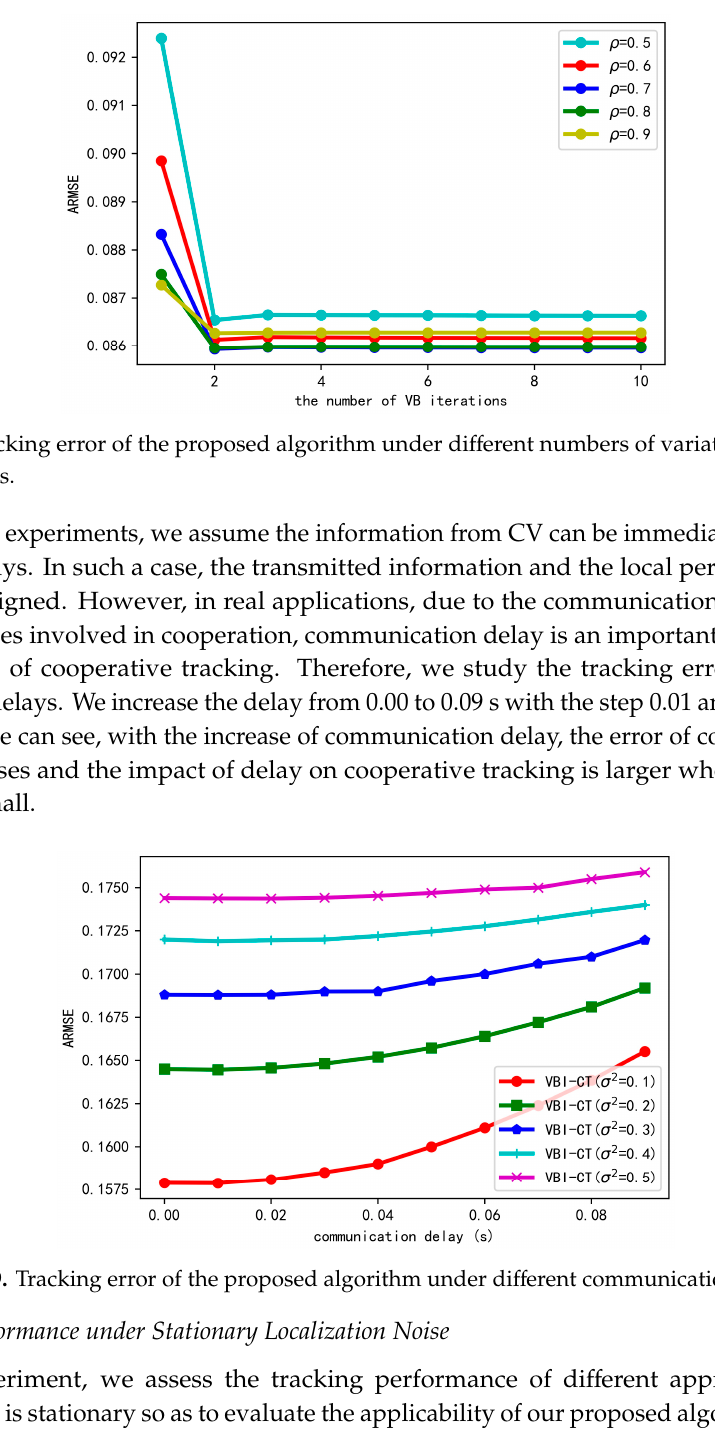
14 of 18 Figure 7. Tracking error of the proposed algorithm with different forgetting factor. The number of iterations in VB inference is an important factor affecting the tracking behavior. Generally, with the increase of iterations, variational distribution can approximate the true posterior distribution more precisely, thus resulting in better tracking performance. However, too many iterations will bring about heavier computational burden and reduce the tracking speed. Therefore, we investigate how the tracking error varies with the increased number of VB iterations. The result